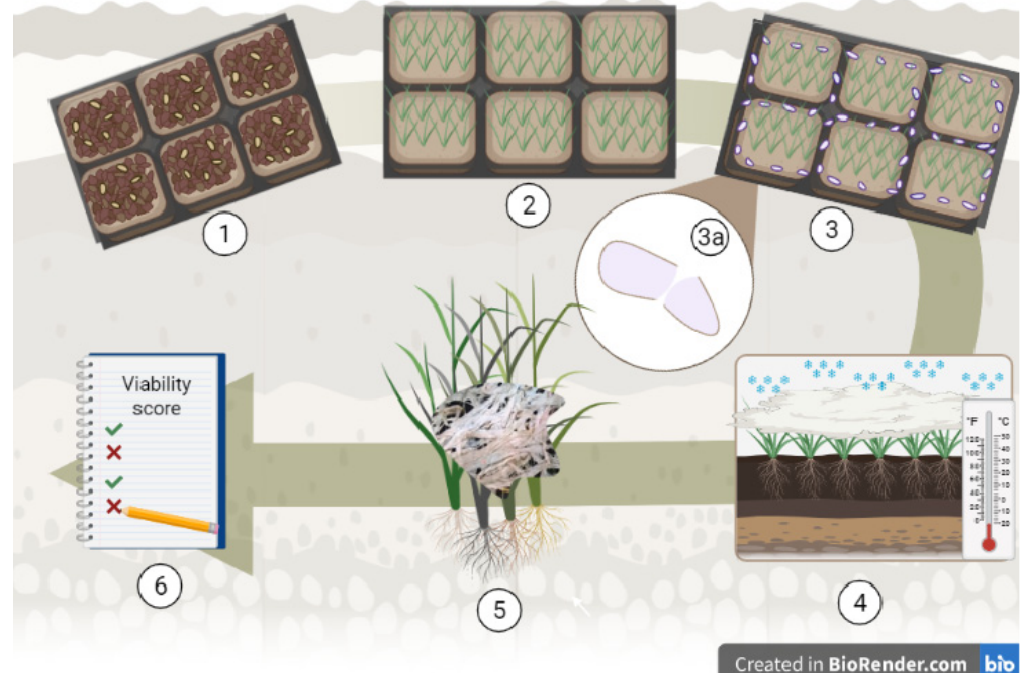
Figure 7. Schematic of the field experiment in an artificially-enriched infection background (AIB) nursery. (1) Sowing the plots; (2) Growing young plants up to the stage of 3 true leaves (BBCH scale 21); (3a) Soaking of the crushed grain of spring oats or barley with Microdochium nivale ; (3) Uniform scattering of the infected grains on plots; (4) Wintering plots under snow cover, infestation of plants under snow or immediately after snow melt; (5) Visual assessment of plots as soon as the snow has melted and the field is dry enough to be able to do phenotyping of the samples (5–7 days after snow melt); (6) Disease scoring.